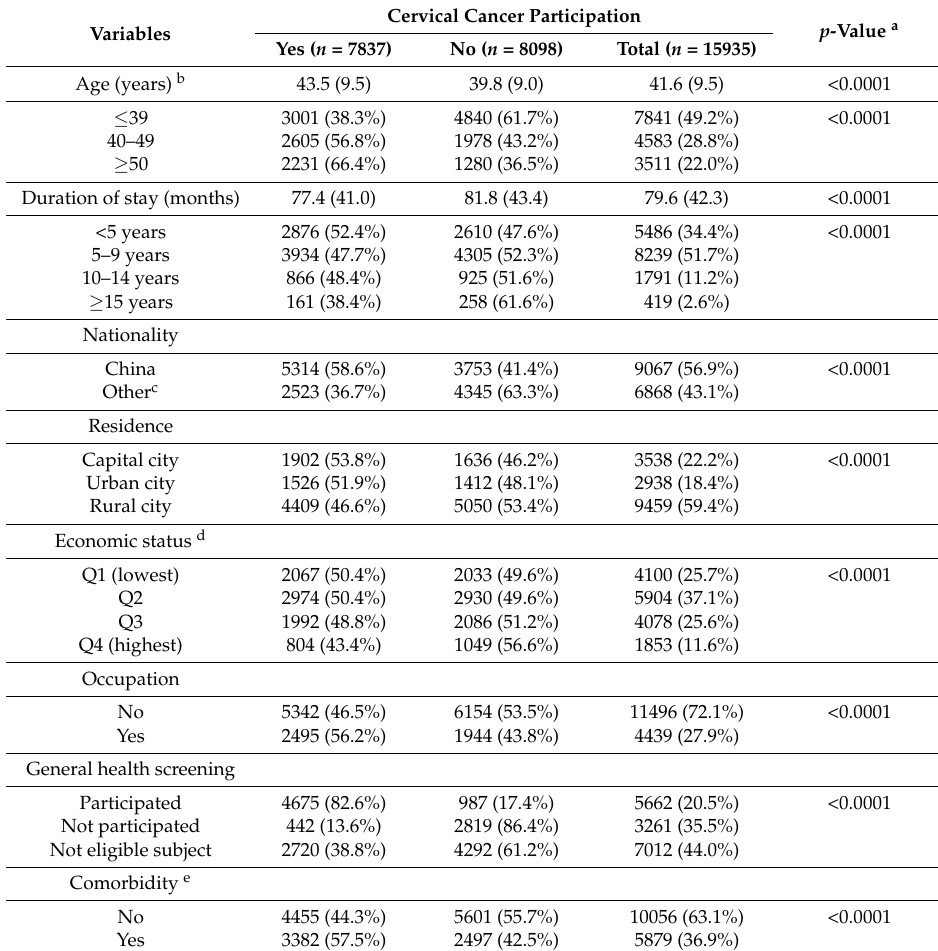
Table 1. Descriptive statistics by cervical cancer screening participation among married immigrant females with South Korean husband